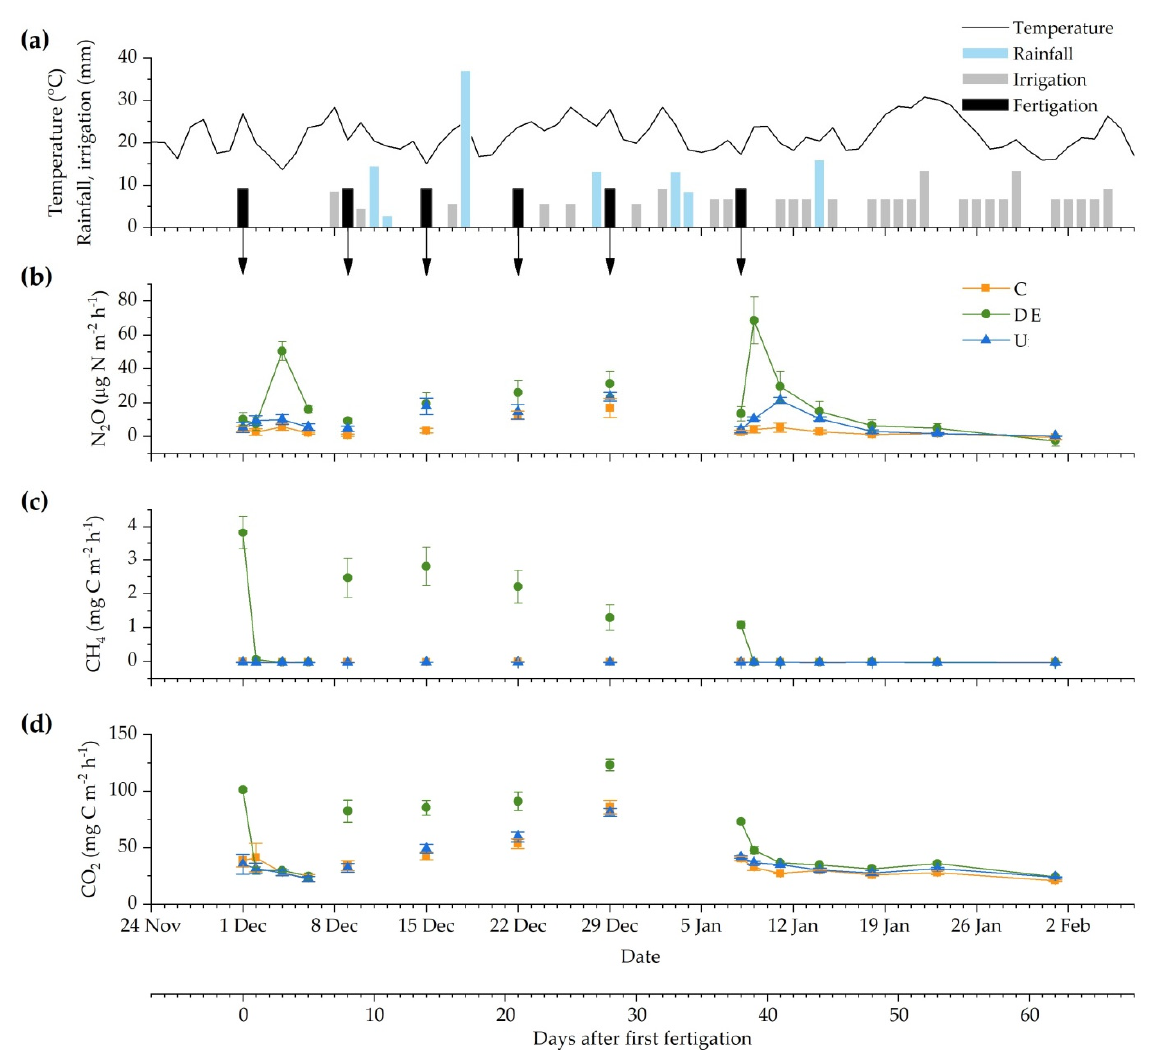
Figure 3. ( a ) Mean air temperature (°C) and rainfall, irrigation, and fertigation (mm). Daily fluxes of ( b ) N 2 O, ( c ) CH 4 , and ( d ) CO 2 from the control (C), dairy effluent (DE), and urea (U) application during the 62-day monitoring period. Arrows indicate fertigation events. The bottom axis shows the days after the first fertigation (day 0) and corresponding dates. Bars represent the standard error of the mean.